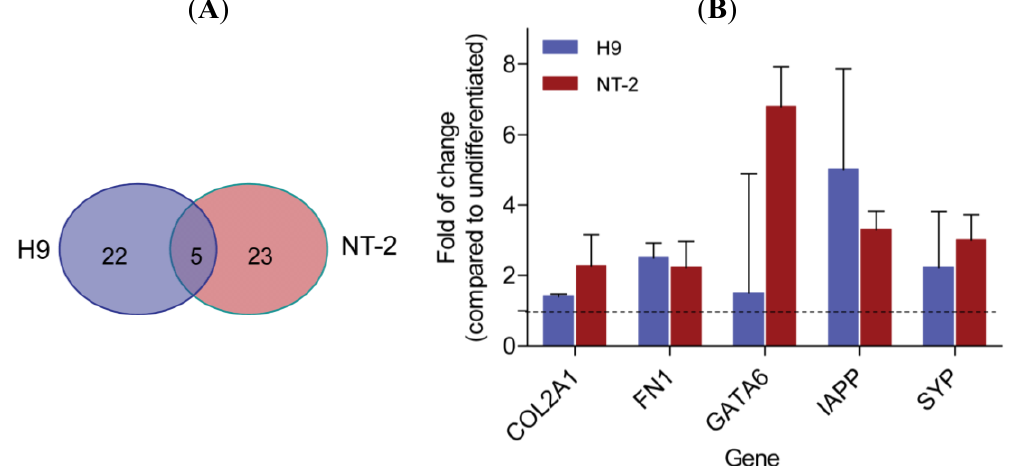
Figure 3. Comparison of mRNA expression of down-regulated stemness phenotype markers in H9 and NT-2 cells upon neural differentiation. ( A ) The genes expression overlapping between H9 and NT-2 cell lines represented by the use of Venn diagrams, showing the number of down-regulated genes in H9 (green) and in NT-2 (yellow); ( B ) The expression of the same six genes was down-regulated in both cell systems (H9 and NT-2) when compared with their fold change to the expression level in undifferentiated cell cultures by using TaqMan ® Human Stem Cell Pluripotency microfluidic